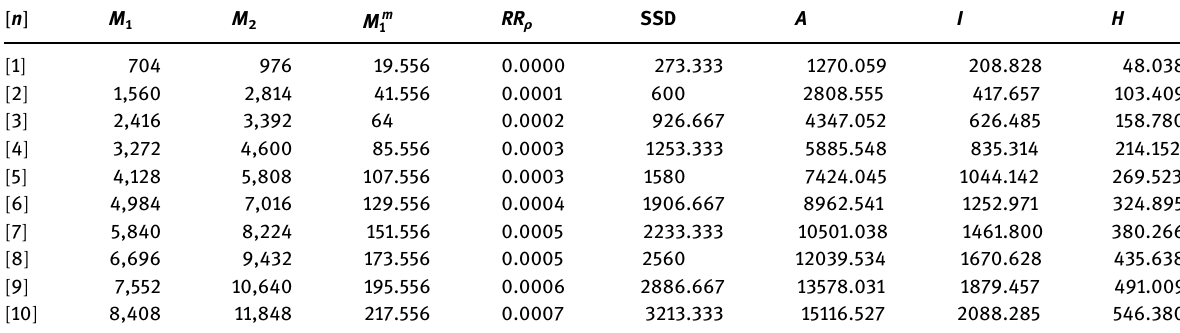
Table 3: Computation of topological invariants by the help of M - polynomial of TM - TCNB